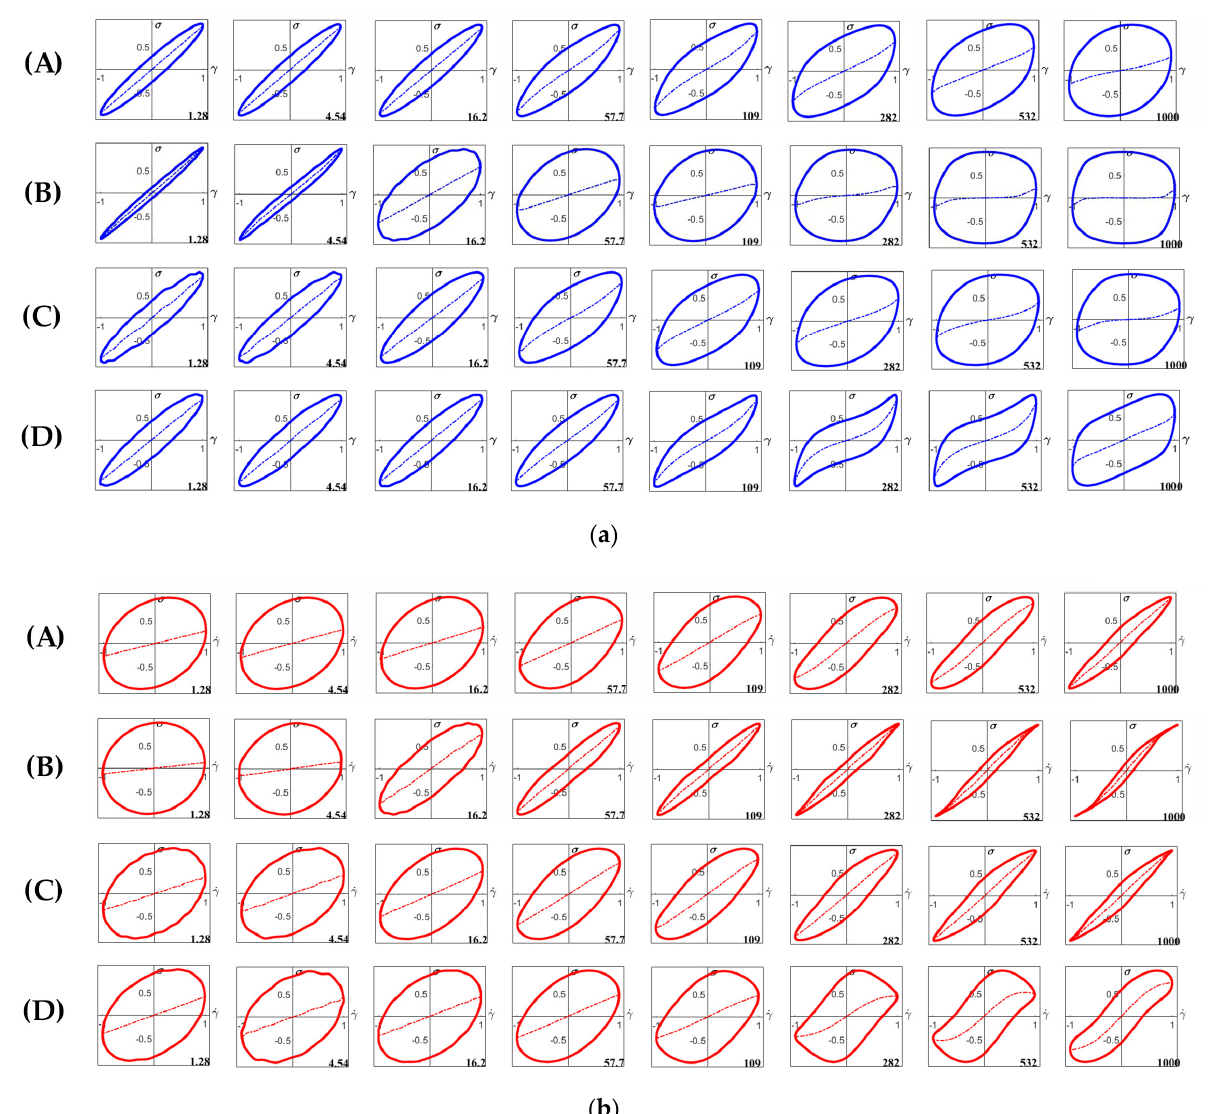
Figure 10. ( a ) Lissajous plots of stress versus strain ( τ ( γ )) for starch gels in the sugar–acid system with shear strains ( γ ) of (from left to right) 1.28%, 4.54%, 16.2%, 57.7%, 109%, 282%, 532% and 1000% at 25 °C: ( A ) TS, ( B ) RS, ( C ) WTS, and ( D ) WRS. Dashed curves inside the loops indicate the contribution of the elastic stress to the total stress [34]. ( b ) Lissajous plots of stress versus strain rate ( τ ( 𝛾(cid:4662) )) for starch gels in the sugar–acid system with shear strains ( γ ) of (from left to right) 1.28%, 4.54%, 16.2%, 57.7%, 109%, 282%, 532% and 1000% at 25 °C: ( A ) TS, ( B ) RS, ( C ) WTS, and ( D ) WRS. Dashed curves inside the loops indicate the contribution of the viscous stress to the total stress [34].